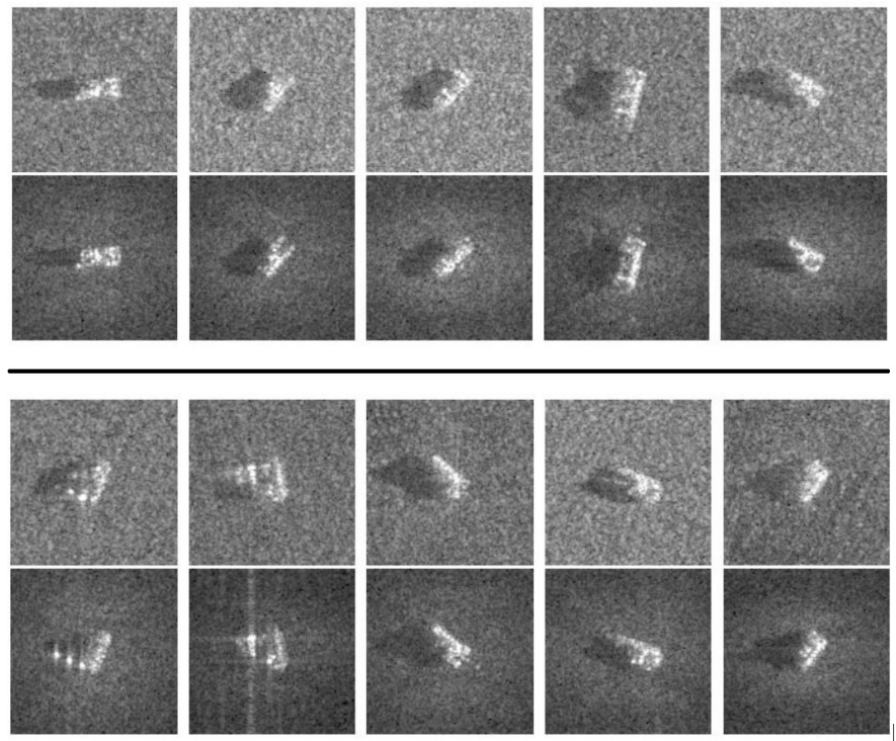
Figure 2. Images from each class of SAMPLE (top) next to MSTAR (bottom); 2S1, BMP2, BTR70, M1, M2 (above), and M35, M548, M60, T72, ZSU23-4 (below). Reproduced with permission from [12]. 2019, SPIE.